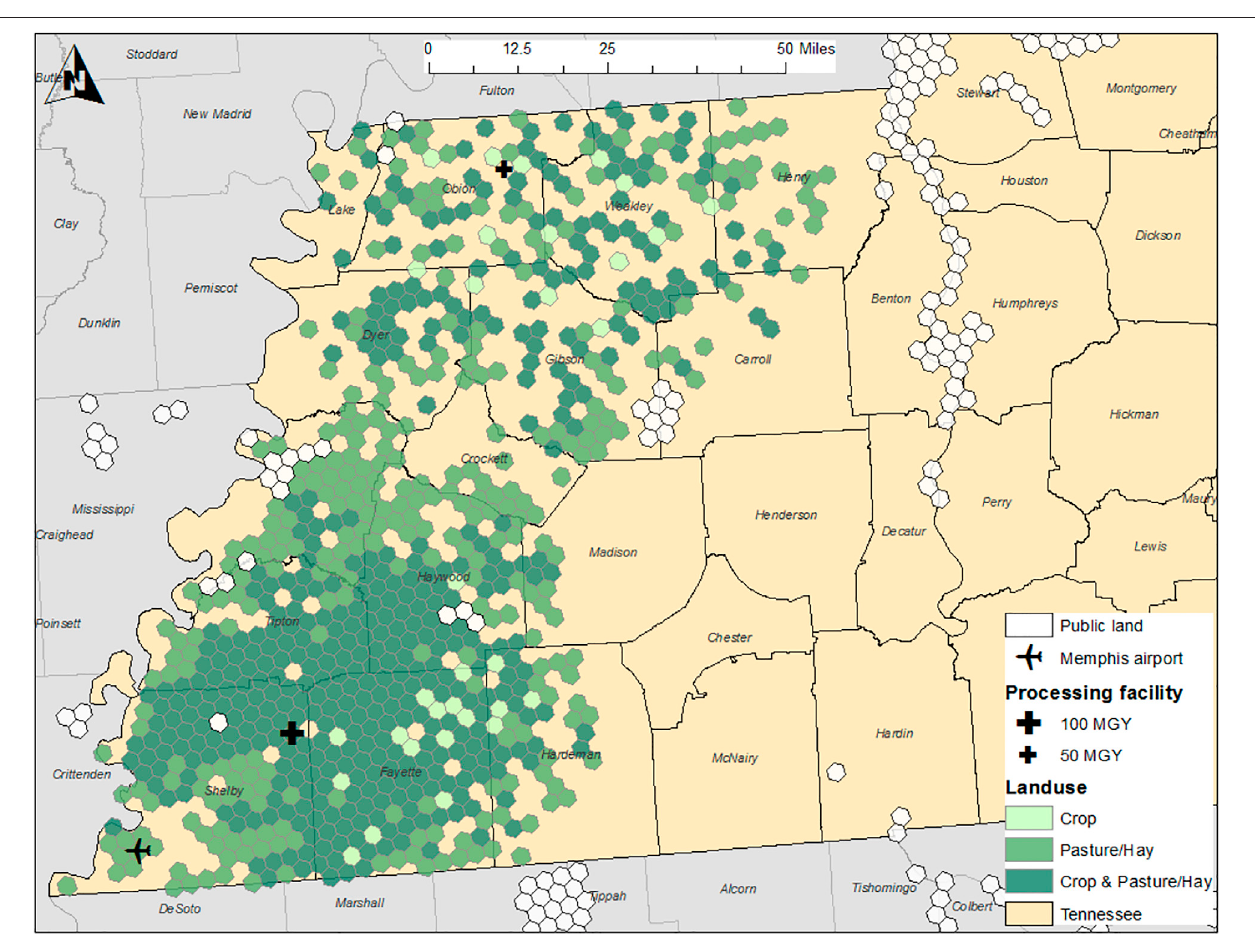
FIGURE 2 | Optimal land use and facility locations under the